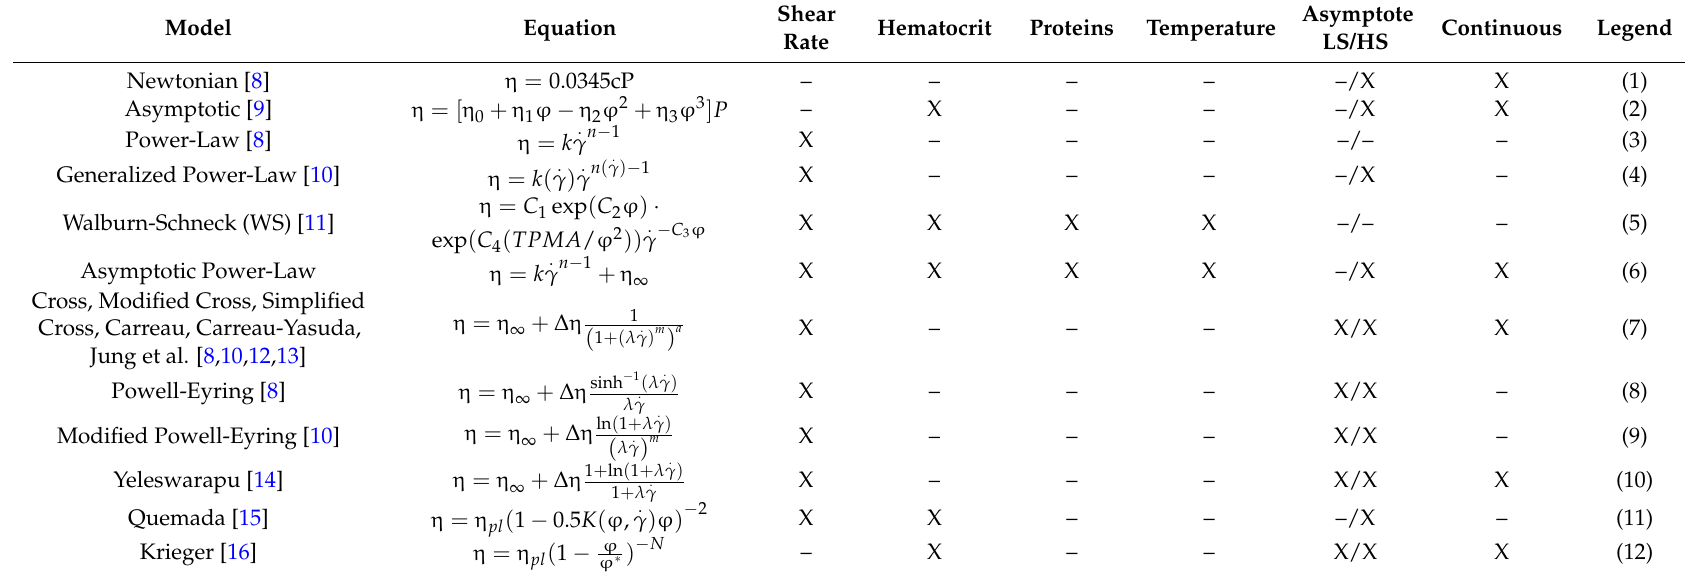
Table 1. Models of blood viscosity including a list of model features. X indicates the model has the feature and—indicates the model lacks the feature. (LS—low shear, HS—high